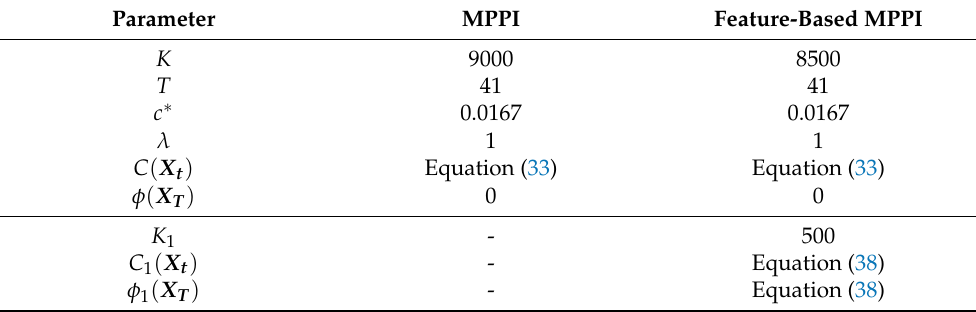
Table 4. Controller parameters of the standard MPPI and the feature-based MPPI approaches.